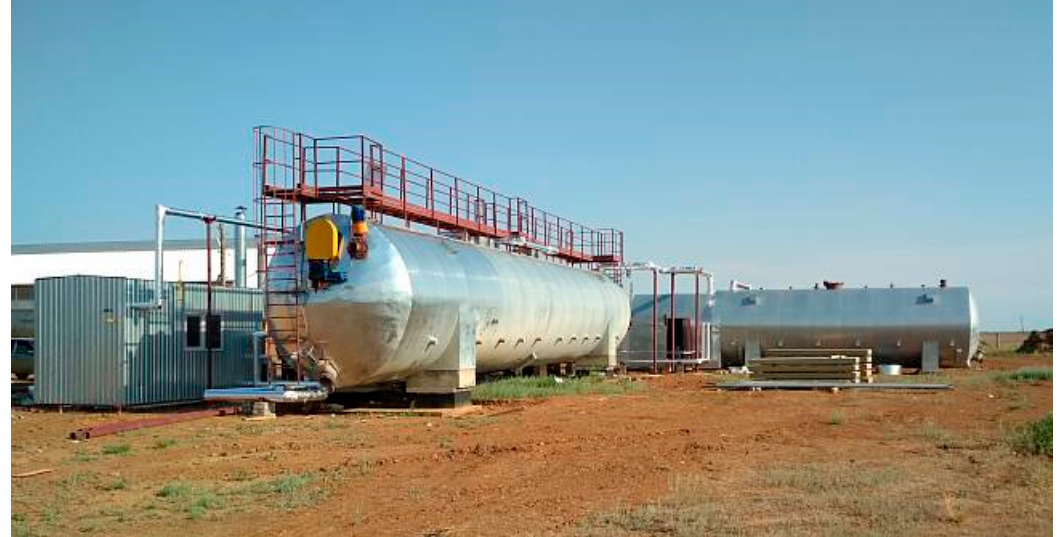
Figure 1. Typical for the Russian Federation block-modular anaerobic bioreactors based on railway tanks (with the permission of SelkhozBioGaz LLC) [39].